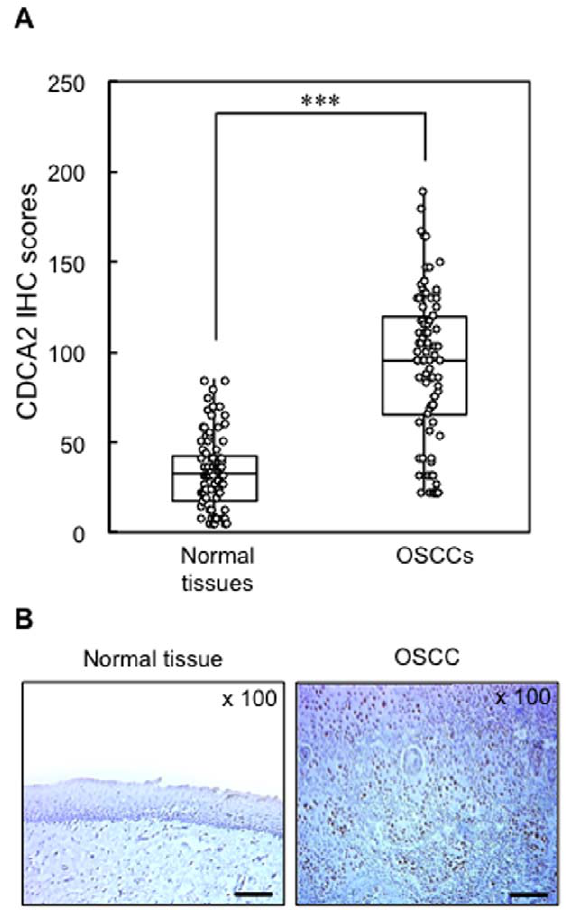
Figure 5. Evaluation of CDCA2 expression in normal oral tissues and primary OSCCs. ( A ) The status of CDCA2 protein expression in primary OSCCs and paired normal oral tissues from 85 patients based on the IHC scoring system. The CDCA2 IHC scores of normal oral tissues and OSCCs range from 2.5 to 90.0 (median, 30.0) and 20.0 to 190.0 (median, 95.0), respectively. The CDCA2 protein expression level in OSCCs is significantly higher (*** P , 0.001, Mann- Whitney’s U test) than that in normal oral tissues. ( B ) Representative IHC results of CDCA2 in normal oral tissue and primary OSCC ( 6 100 magnification. Scale bars, 100 m m). Strong CDCA2 immunoreaction is detected in OSCCs, whereas the normal oral tissues show almost negative